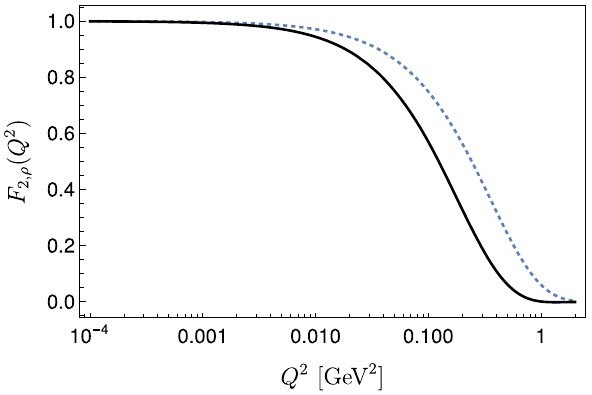
Fig. 18 The effective form factor Eq. (9), evaluated for the ρ system. Full black line for the transverse polarisation and dotted blue line for the longitudinal